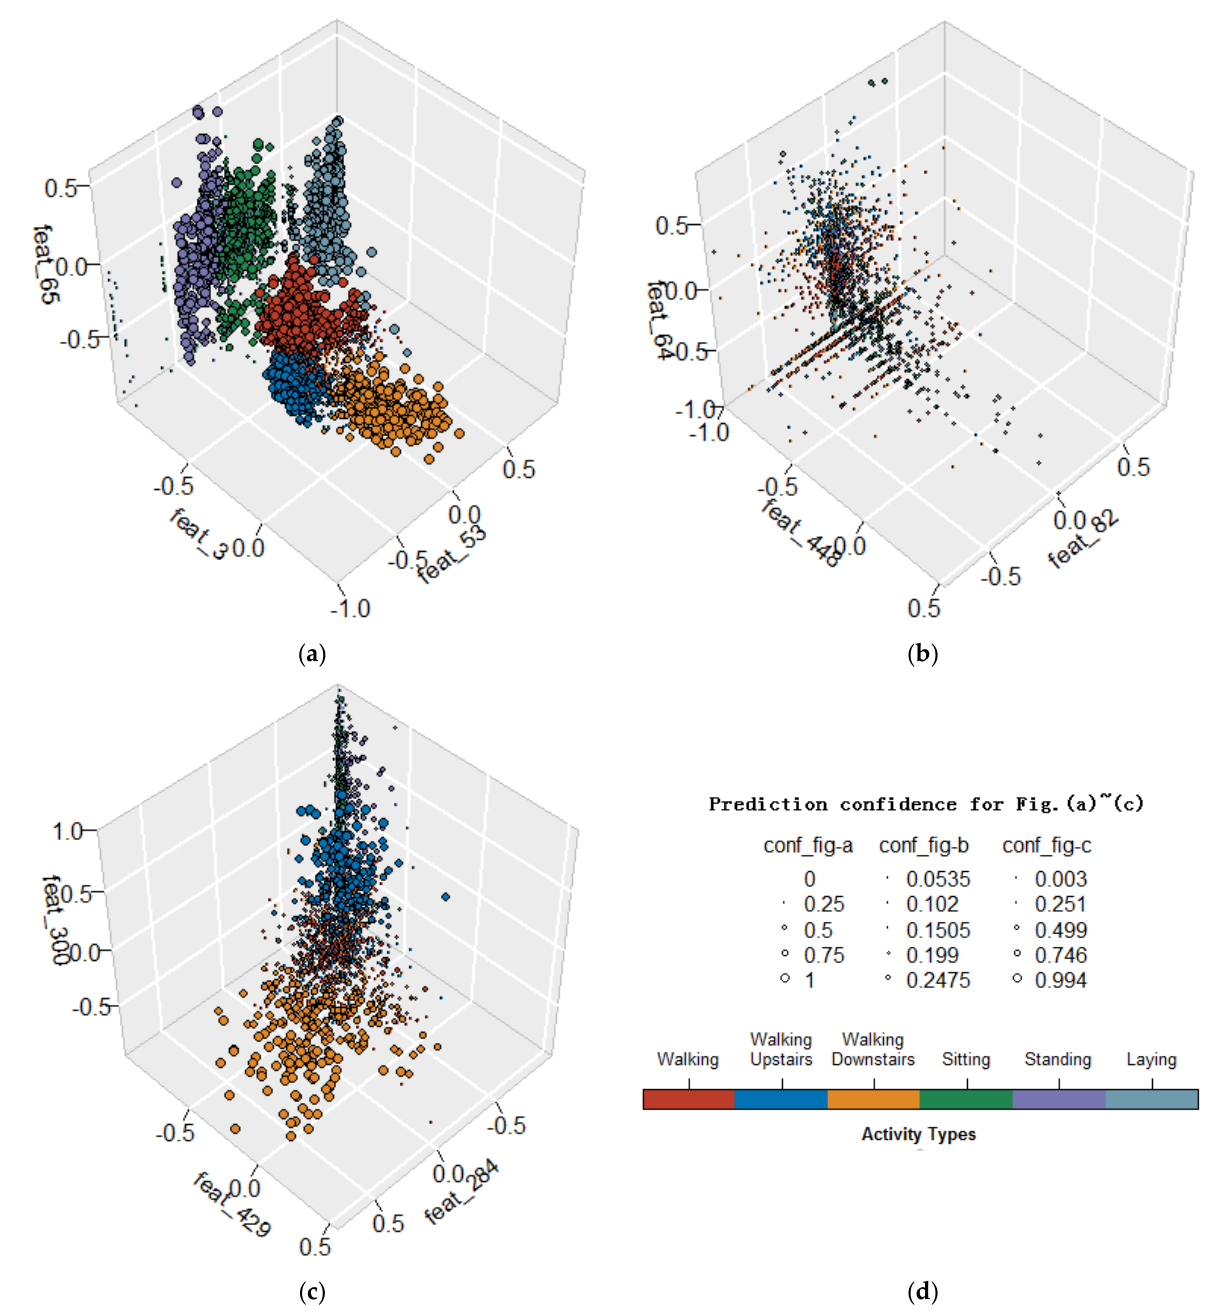
Figure 3. The prediction results for test data using the constructed 3 subsets with each having a capacity of three features from the pre-extracted 561 features in the UCI-HAR dataset. ( a – c ) Schematic illustrations of the recognition results for test data consisting of feature subset T 3, W 3, and R 3, respectively; ( d ) two legends of the above illustrations, one using point sizes to distinguish different confidence levels, the other using different colors to represent different activity types.